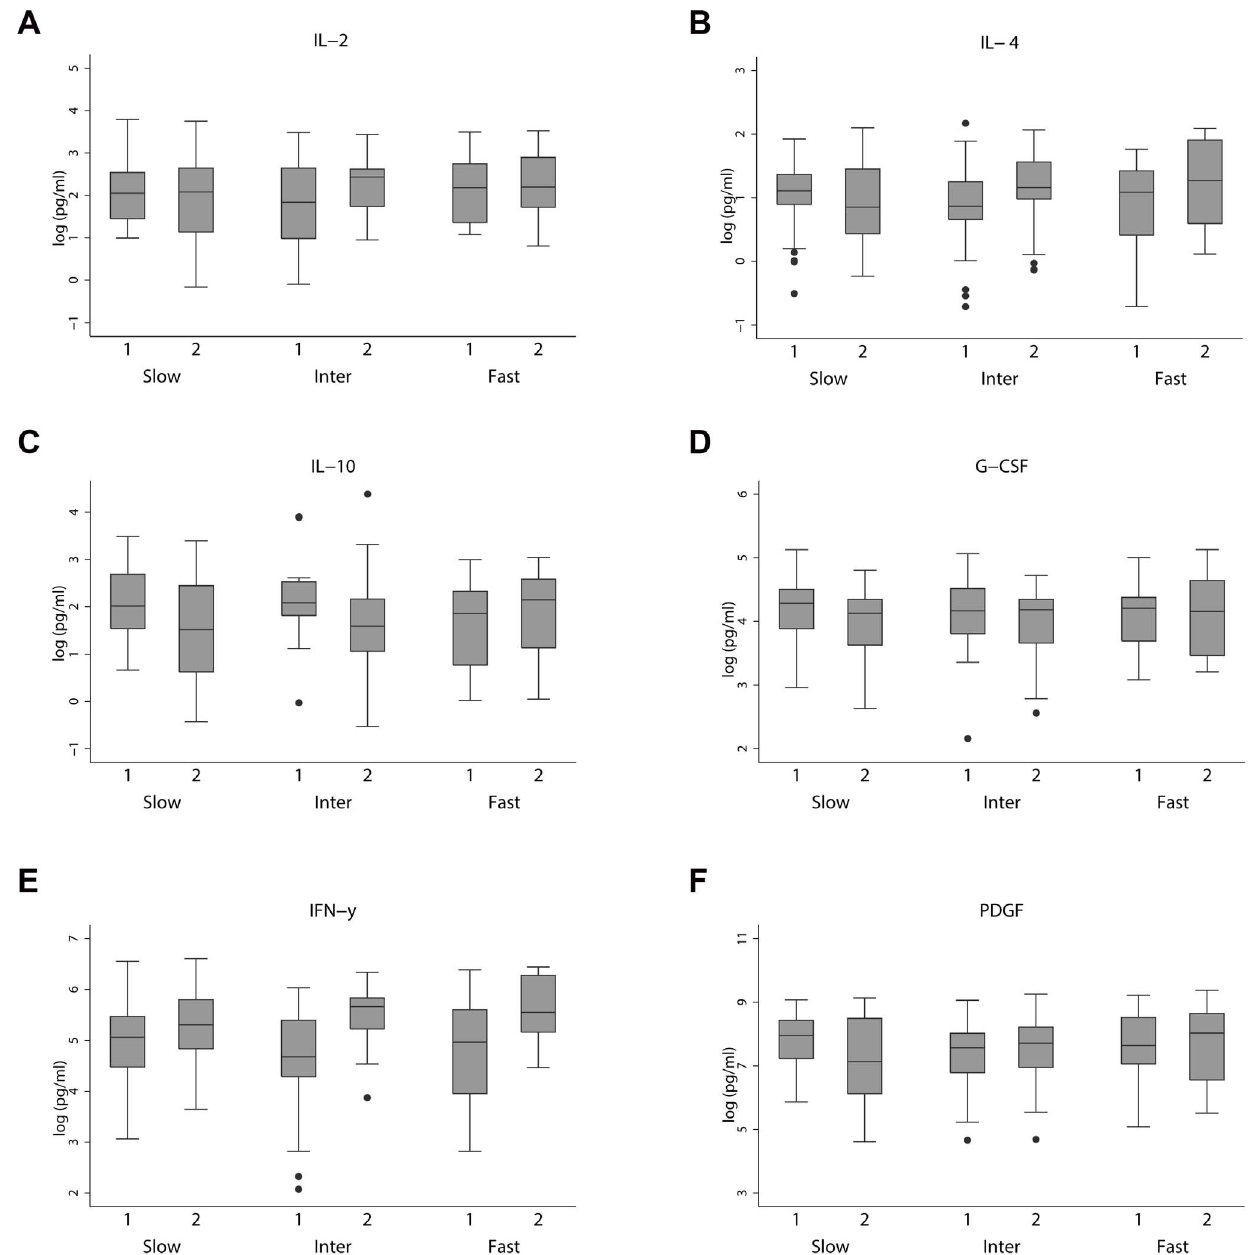
Figure 2. Inflammatory proteins levels at Visit 1 (baseline) and Visit 2 (one year follow up from baseline) for the three ADAS-cog cognitive decline groups. Linear mixed effects models indicated significant yearly changes in the log-transformed IL-2 (figure 2A), IL-4 (figure 2B), IL-10 (figure 2C), G-CSF (figure 2D), IFN- c (figure 2E), and PDGF (figure 2F) (pg/ml) inflammatory protein levels between the three cognitive decline groups, after adjusting for covariates. Slow indicates slow decliner. Inter indicates intermediate decliner. Fast indicates fast decliner Key: 1– Visit 1(Baseline); 2– Visit 2 (one year follow up from baseline).